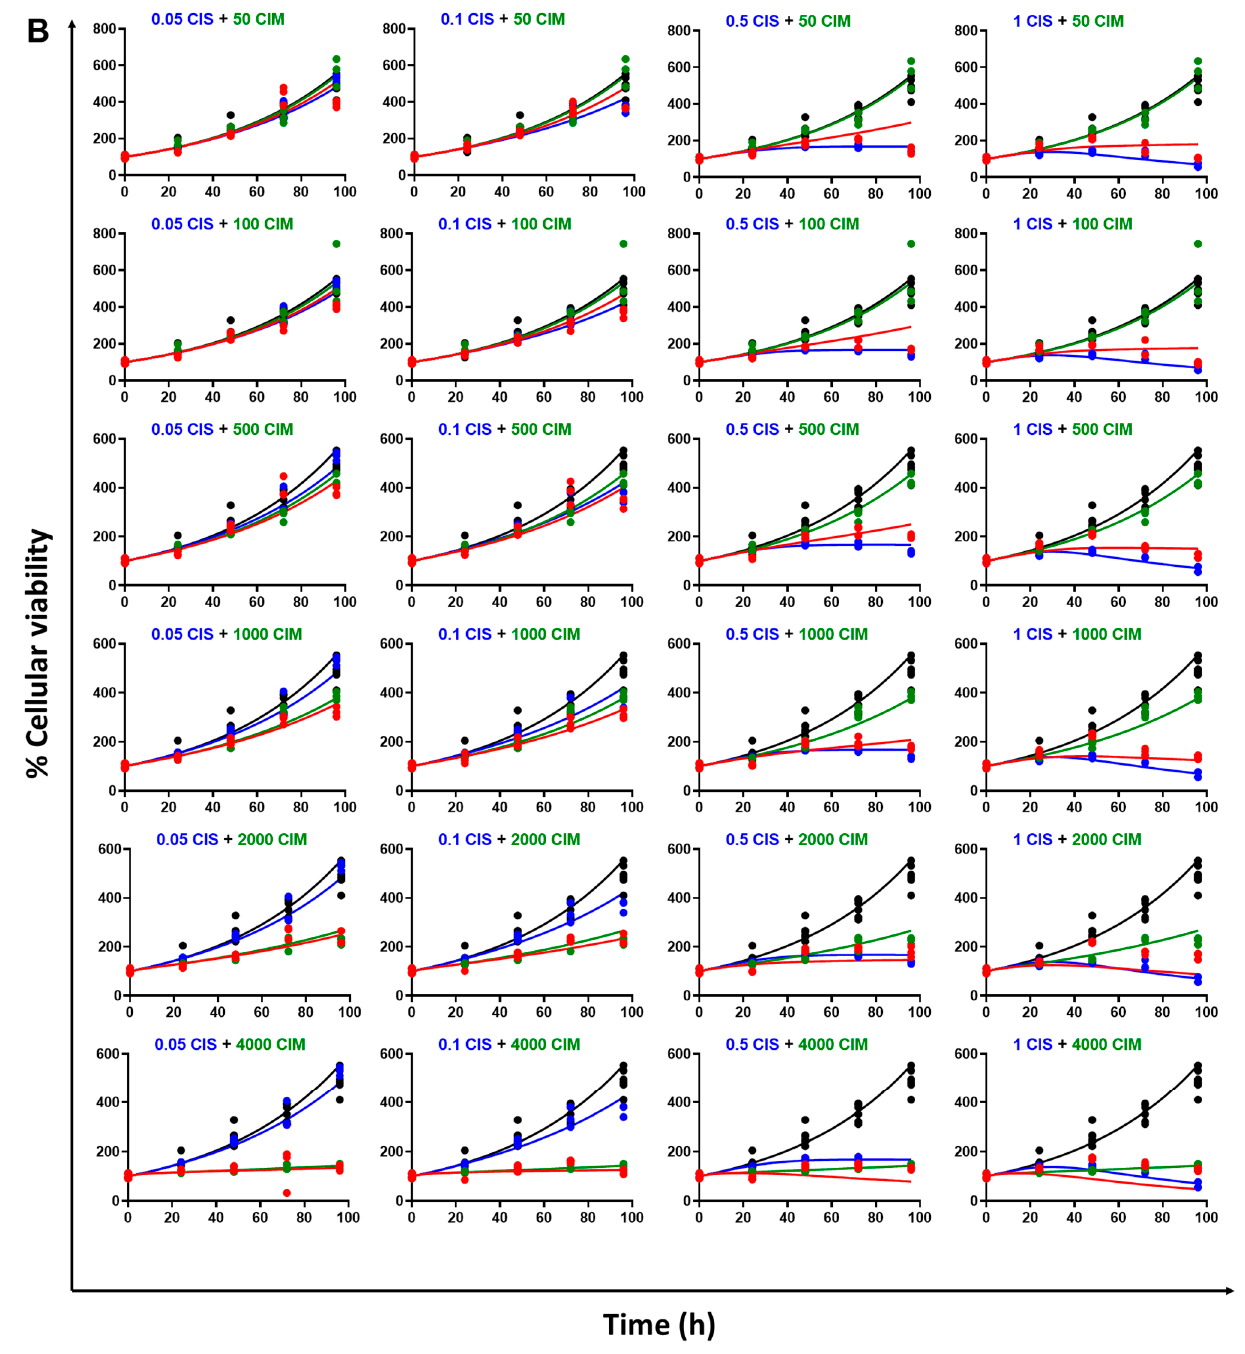
Figure 5. Model fittings (using in vitro cell-level PD model) for the in vitro effects of CIS and CIM as single agents or their combination at the indicated concentrations over time on the cell viability of Huh7 ( A ) and MDA-MB-468 ( B ). Solid circles represent observed data while smooth lines are model fittings. Black, Control; Blue, CIS; Green, CIM; Red, CIS+CIM. The concentrations (in µM) used are indicated at the top of each graph for single agents and combinations.